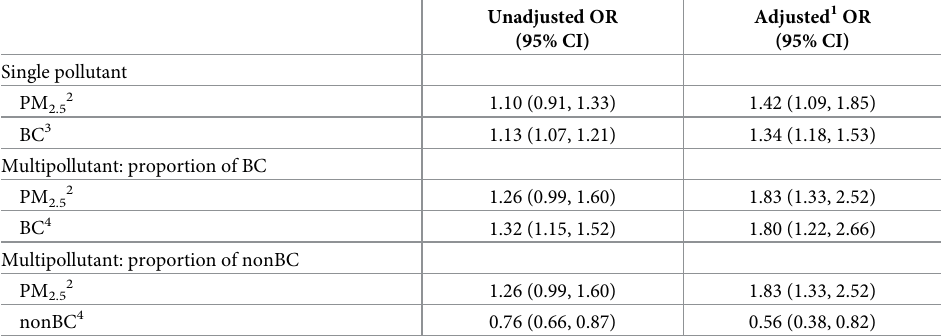
Table 2. Unadjusted and adjusted 1 single and multipollutant logistic regression analyses evaluating the associa- tion of PM 2.5 and black carbon with rhinoconjunctivitis quality of life in young children and adolescents residing in Pampas and Villa,